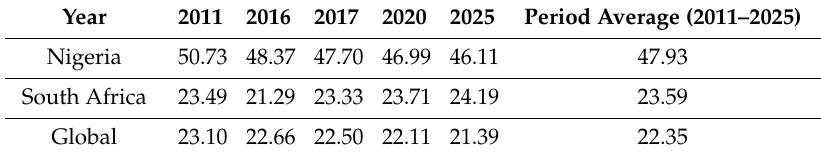
Table 1. Forecast of the size of the informal economies (per % GDP) in Nigeria and South Africa